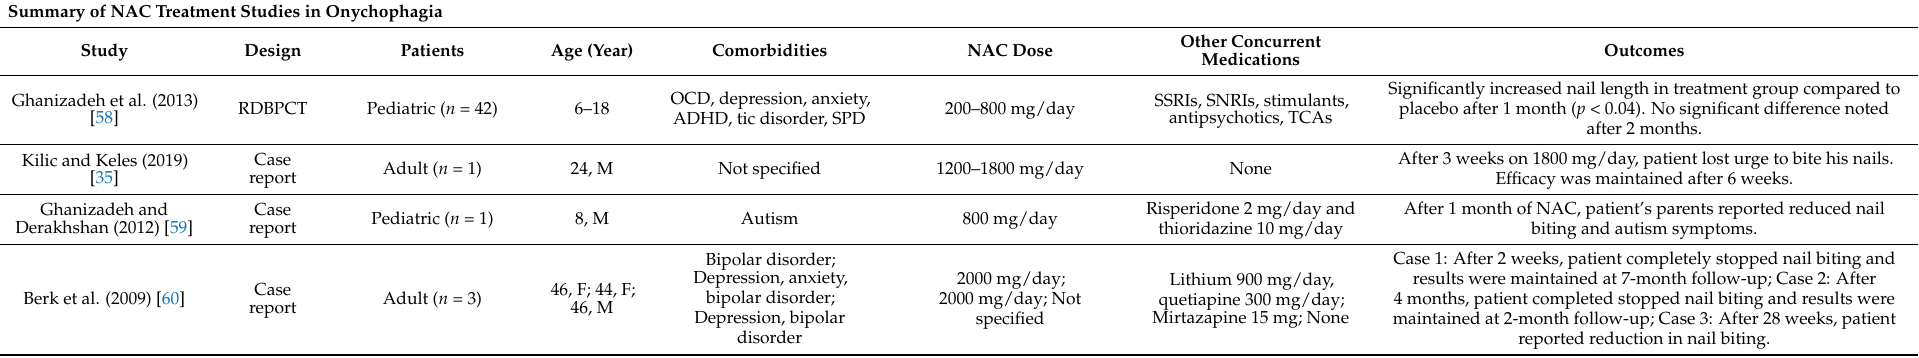
Table 3. Summarizes all NAC treatment studies for onychophagia, which includes one pediatric randomized double-blind controlled trials and three case reports. Summary of NAC Treatment Studies in